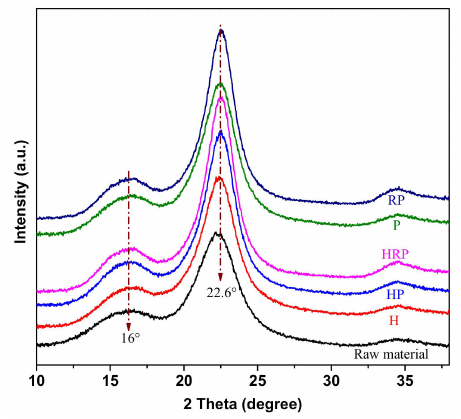
Figure 4. X-ray di ff raction patterns of poplar wood under di ff erent treatment conditions.